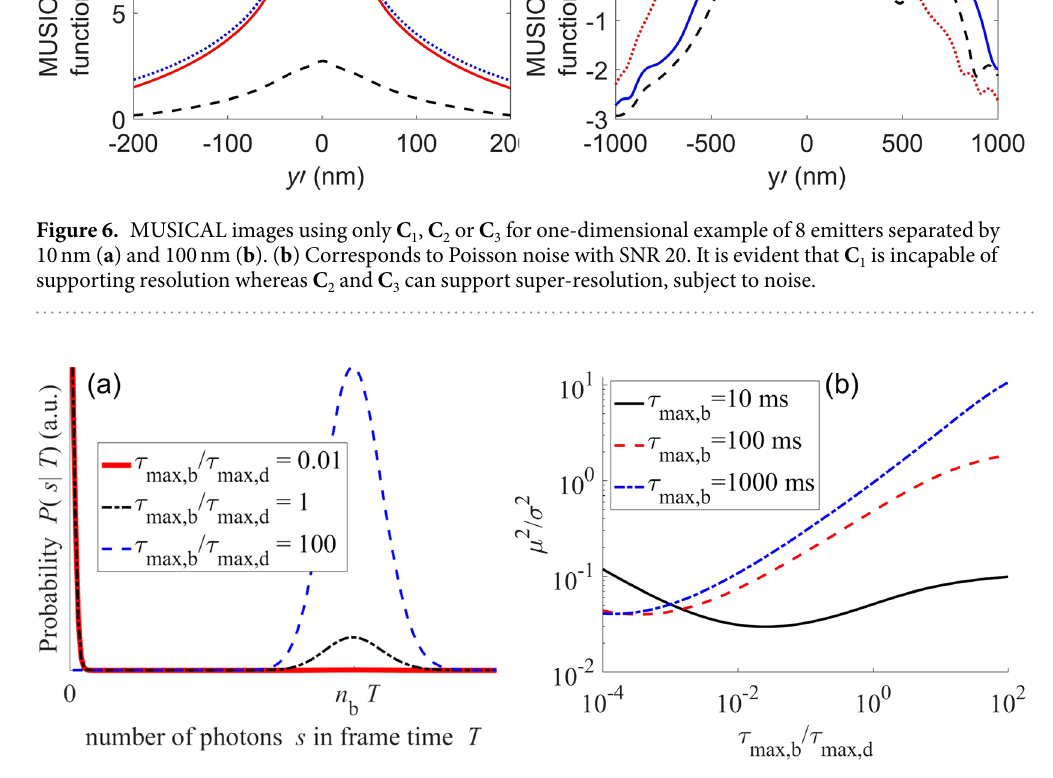
Figure 7. Variety of photon counting statistics are shown in ( a ). For frame acquisition time T = 10 ms, the ratio μ 2 / σ 2 is plotted as a function of τ τ / in ( b ). Additional result is given in supplementary information b d max, max,